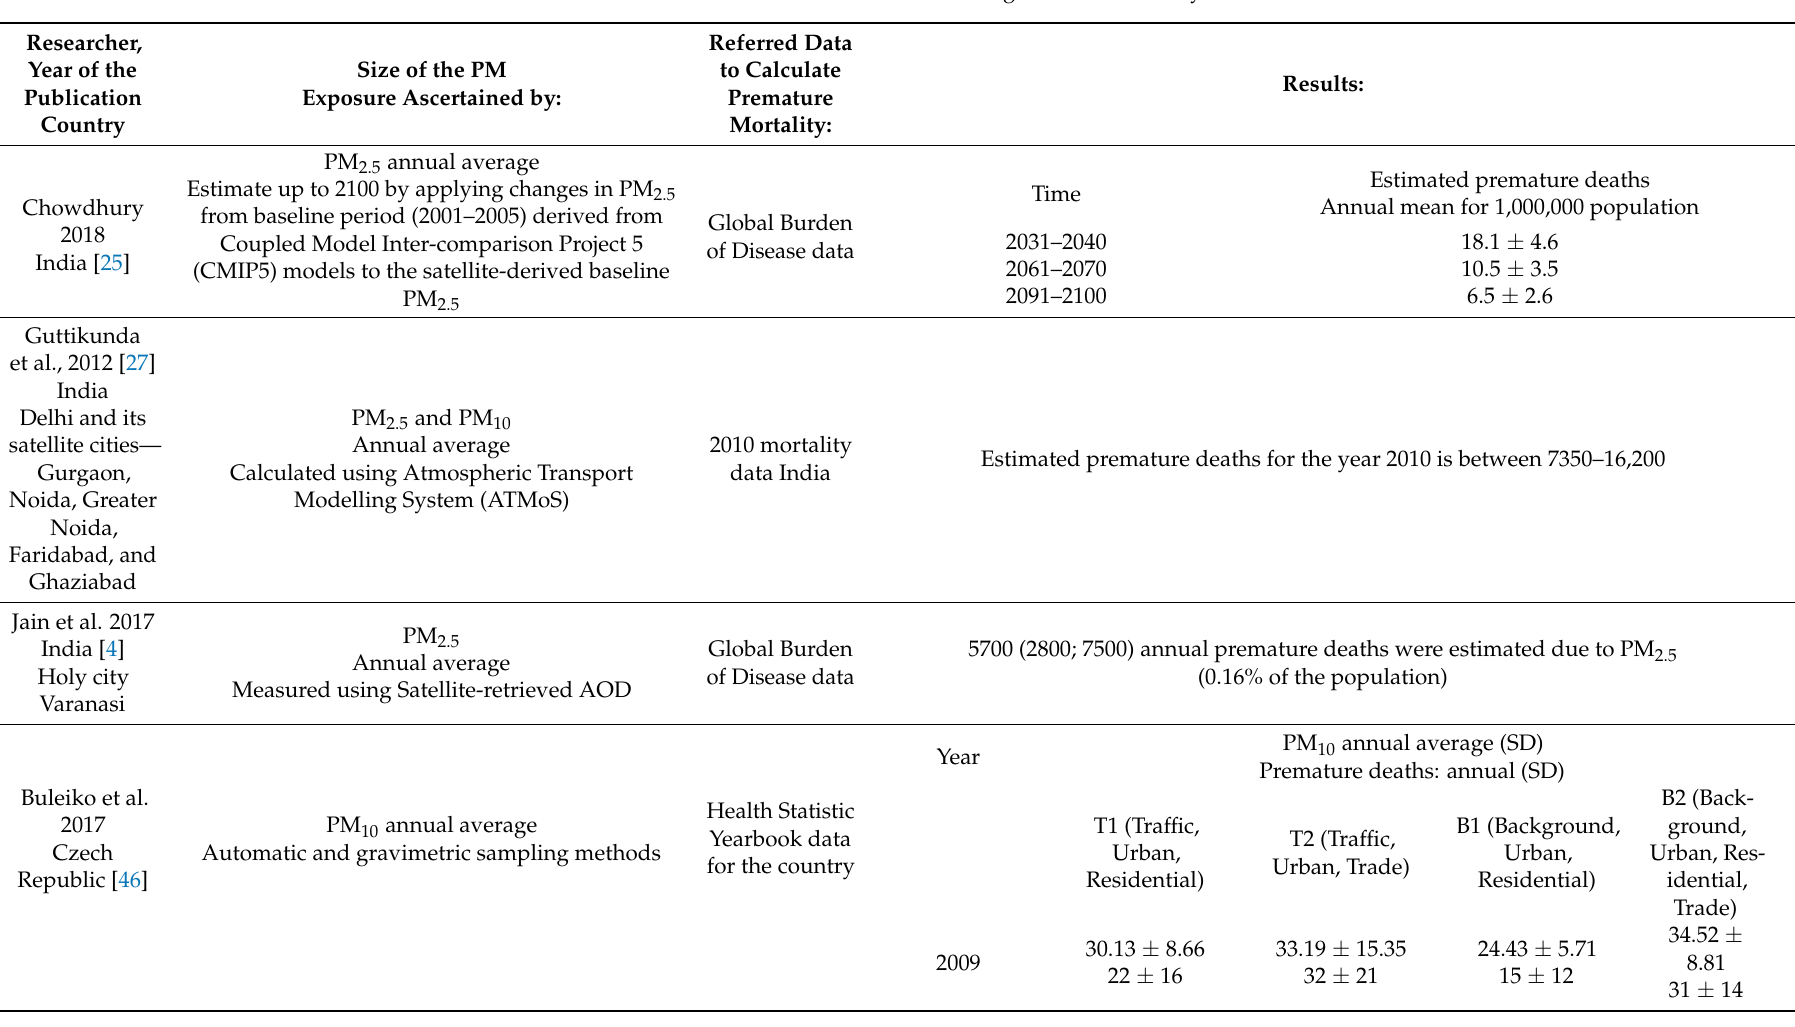
Table 1. Studies that were not eligible for